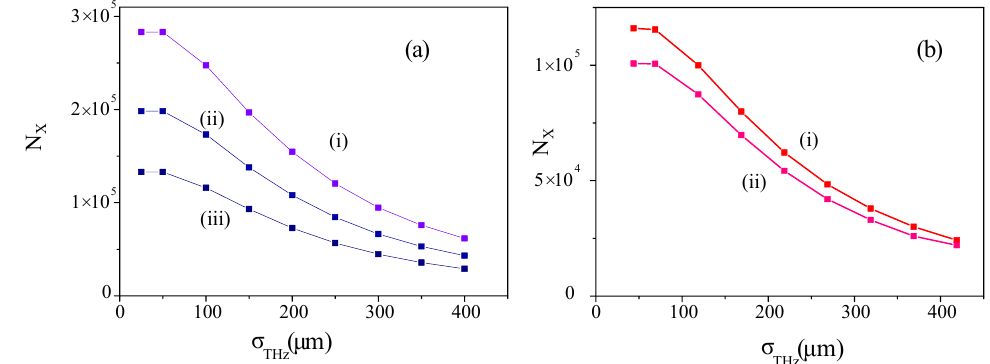
Figure 11. Total number of X-ray photons N X as a function of rms dimension of the THz pulse in the IP, σ THz ( µ m). Window ( a ): λ X = 3 nm, (i) λ w = 3.5 cm, λ THz = 36 µ m; (ii) λ w = 4.5 cm, λ THz = 36 µ